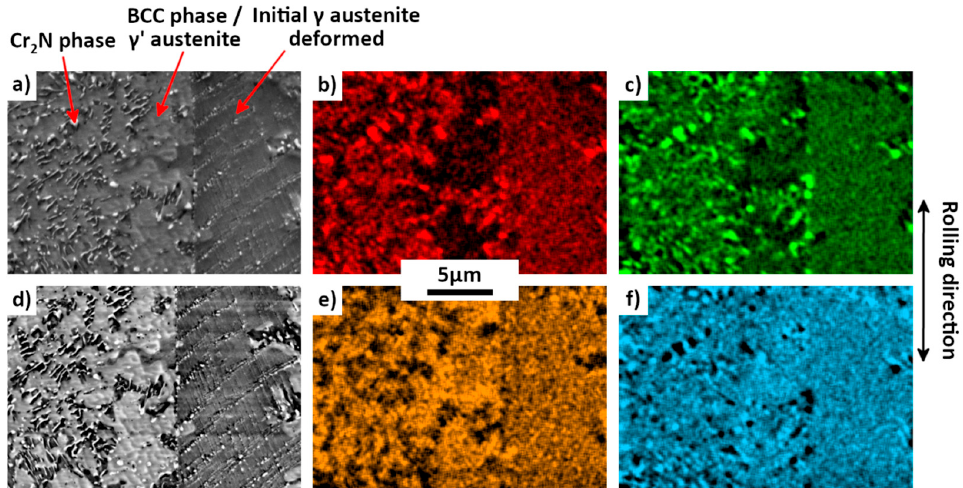
Figure 16. SEM-SE ( a ) and BSE ( d ) micrographs and SEM EDX micrographs ( b , c , e , f ) of a 42%-rolled sample after annealing at 575 °C for 978 h.